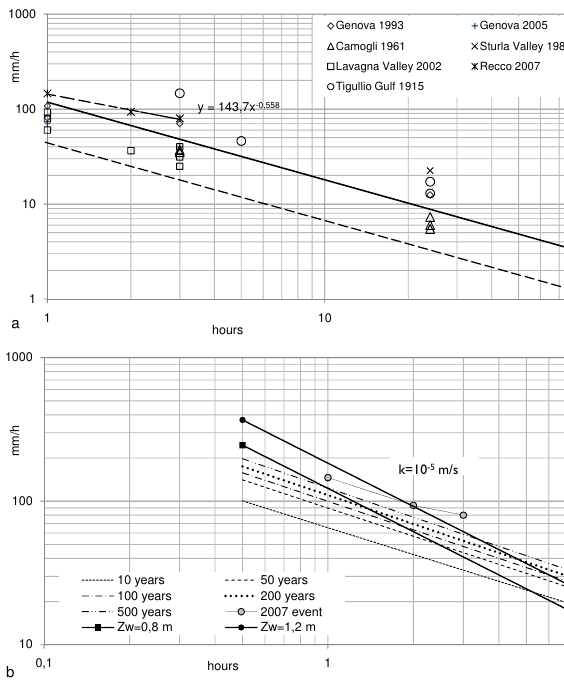
Fig. 4. Rainfall intensity vs duration curves: landslides triggering thresholds according to Cancelli and Nova (1985, dashed lines) and Caine (1980, bold lines) compared to events recorded in Liguria (a) ; critical saturation thickness ( Z w ) for different return periods and permeability threshold – k compared to the 2007 event ( b ; Pradel and Raad, 1993).